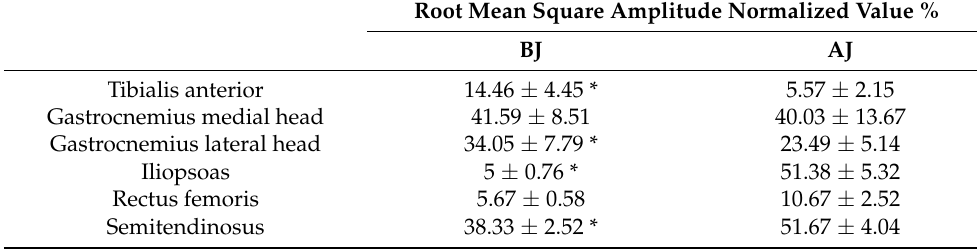
Table 2. The mean electromyography (EMG) data of lower limb muscles through the ground- contact